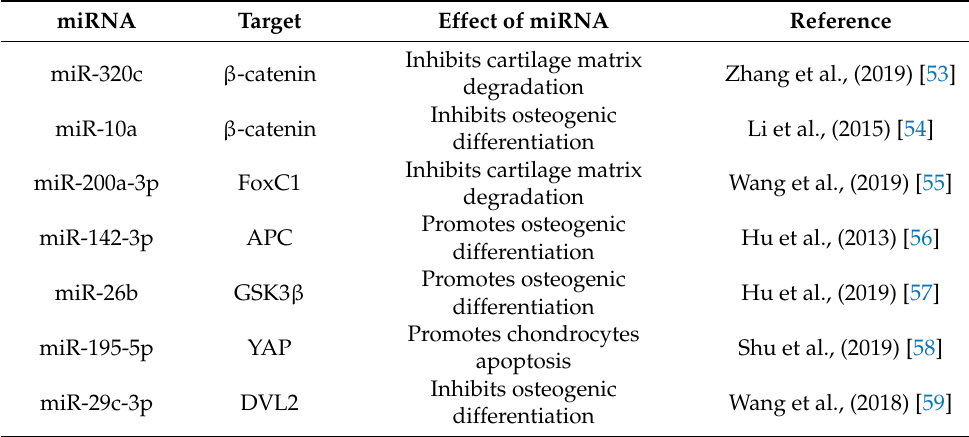
Table 2. miRNAs targeting β -catenin destruction complex and associated proteins in the pathogenesis of OA. miRNA Target Effect of